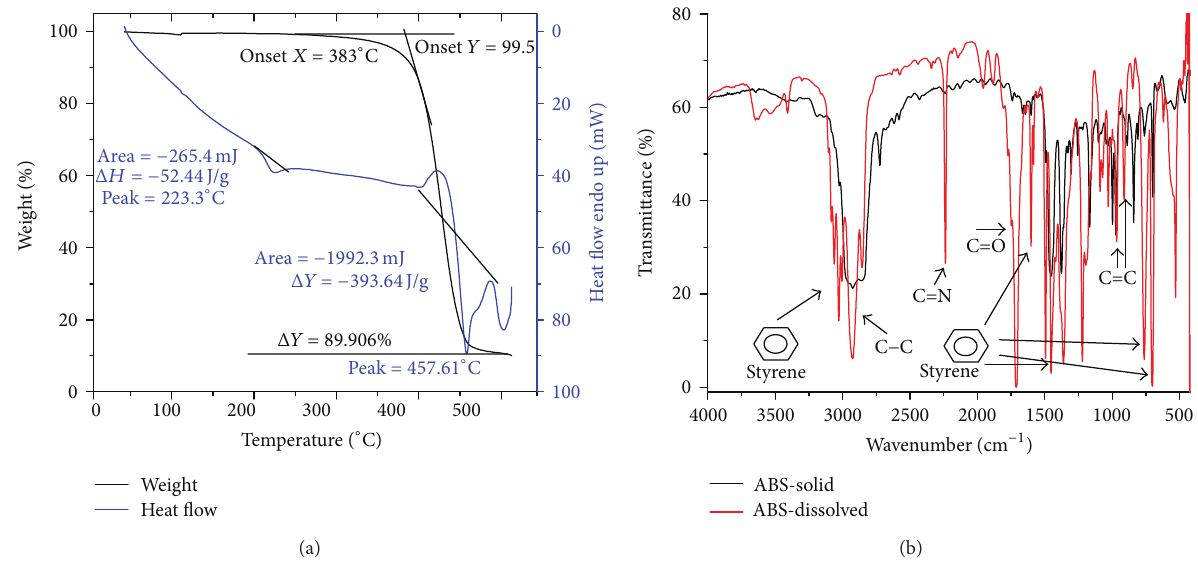
Figure 1: ABS characterization: (a) thermal analysis and (b) infrared